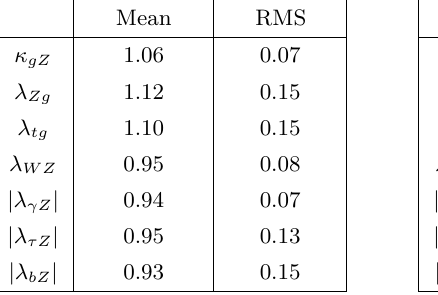
Table 3 . Higgs effective couplings in the κ − λ framework from refs. [58, 59]. The root mean square (RMS) values are symmetrized in our fit procedure and are given in the table on the left (we opt for the conservative choice). The table on the right contains the correlation matrix amongst the seven free parameters defined in the text.